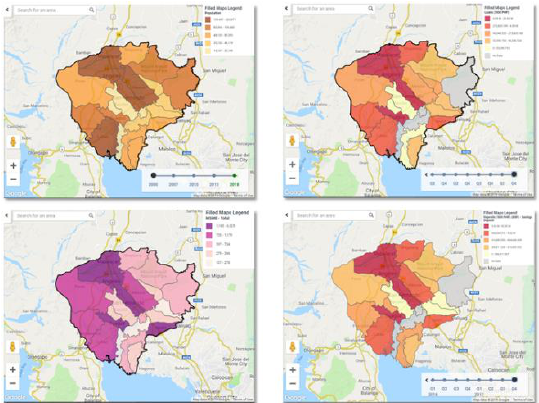
Figure 13. Shows choropleths of the 4 data layers: Population (top left), Loans (top right), MSME Counts (bottom left), and Savings Deposit (bottom right)